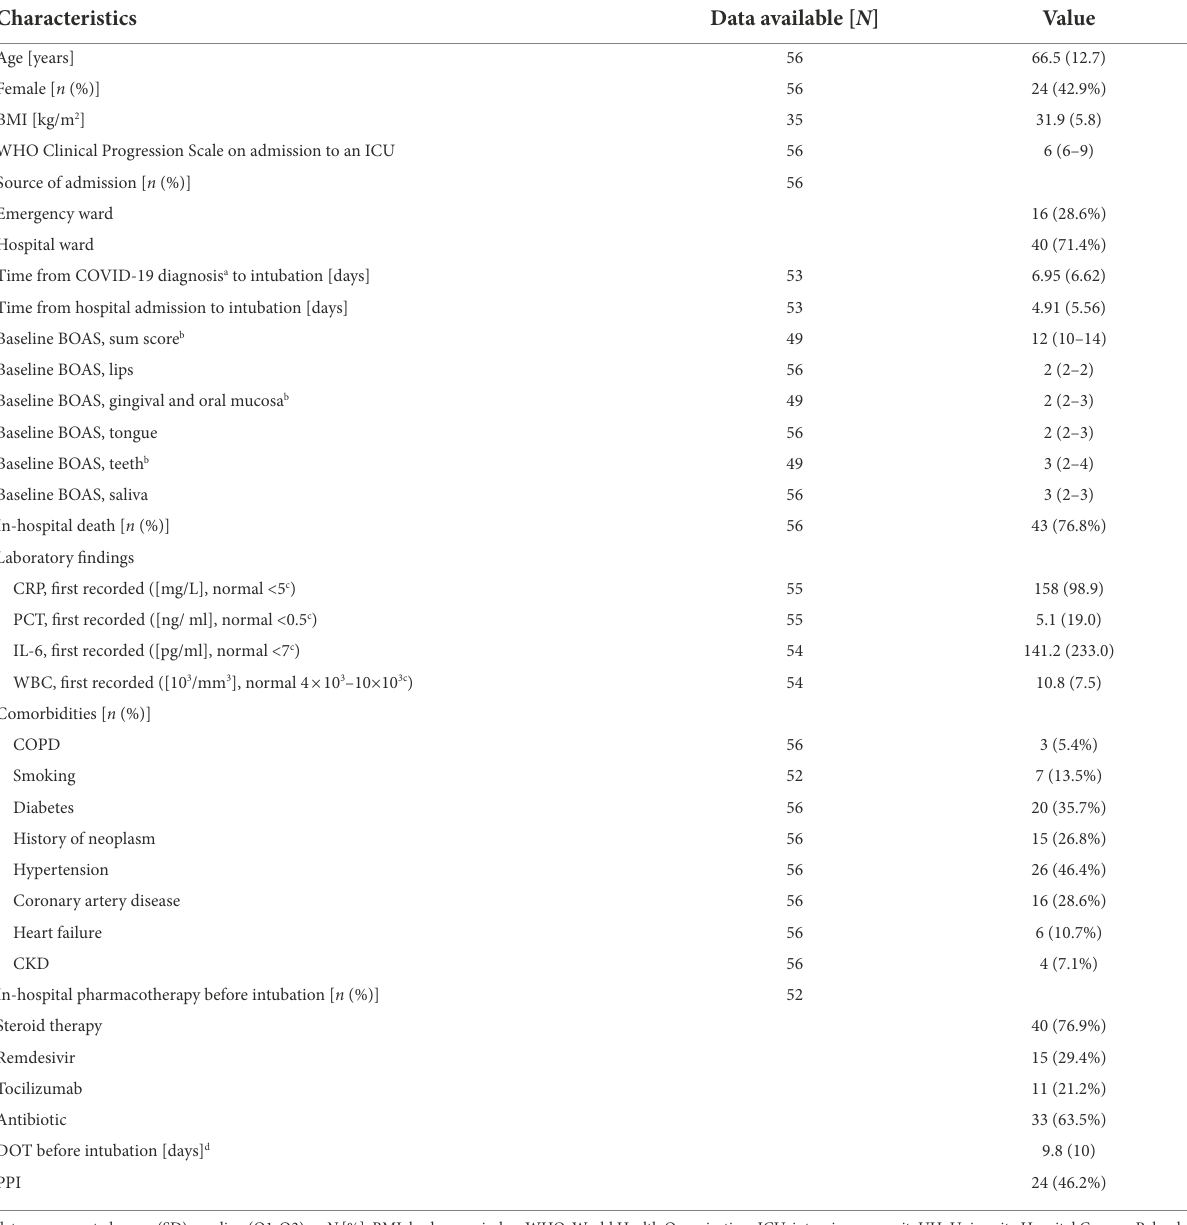
TABLE 1 Baseline characteristics of study participants and outcomes of hospitalization.